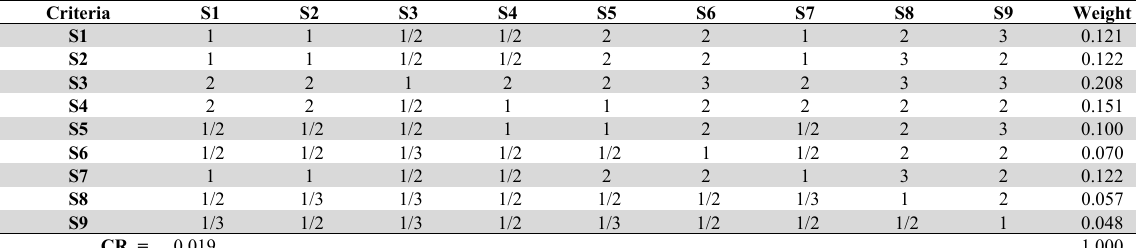
Pairwise comparison matrix aggregation for Strength aspect